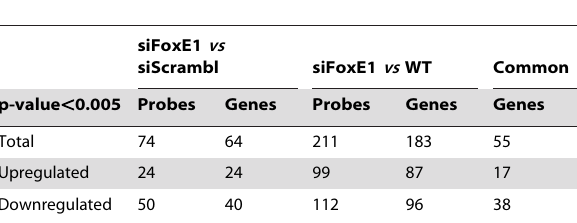
Table 1. Summary of FoxE1 microarray results in PCCl3 cells.